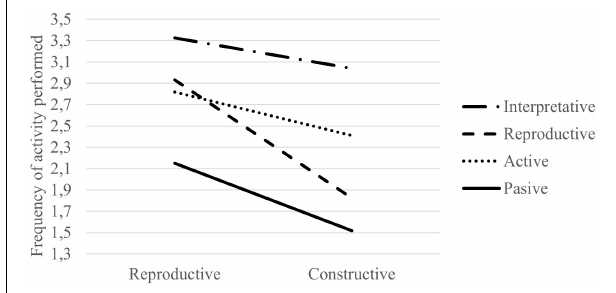
FIGURE 3 | Frequency of use of reproductive and constructive activities for each teachers’